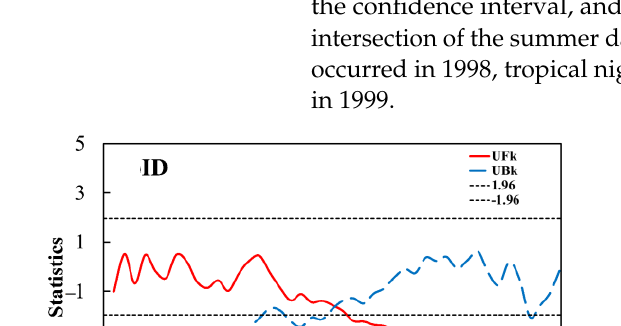
( d ) Figure 8. M – K abrupt change test of the relative temperature indices of the Yangtze River Basin from 1970 to 2014. (a) is TX10, (b) is TN10, (c) is TX90 and (d) is TN90. 3.4.2. Absolute Indices In this paper, the M – K test analysis is carried out on the four absolute indices in the